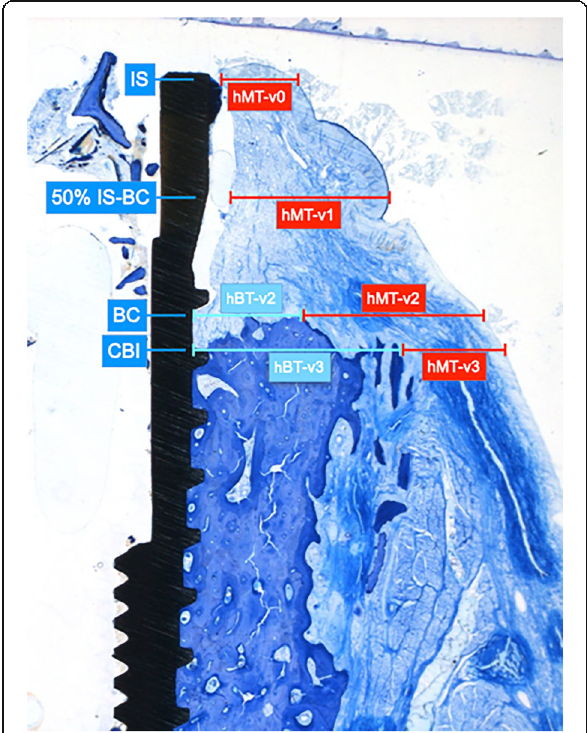
Fig. 2 The following reference points served for the assessment of hMT (red lines) and hBT (turquois lines) values (specimen of the EB group): IS: implant shoulder, BC: bone crest, 50% IS-BC, CBI coronal extension of bone-to-implant